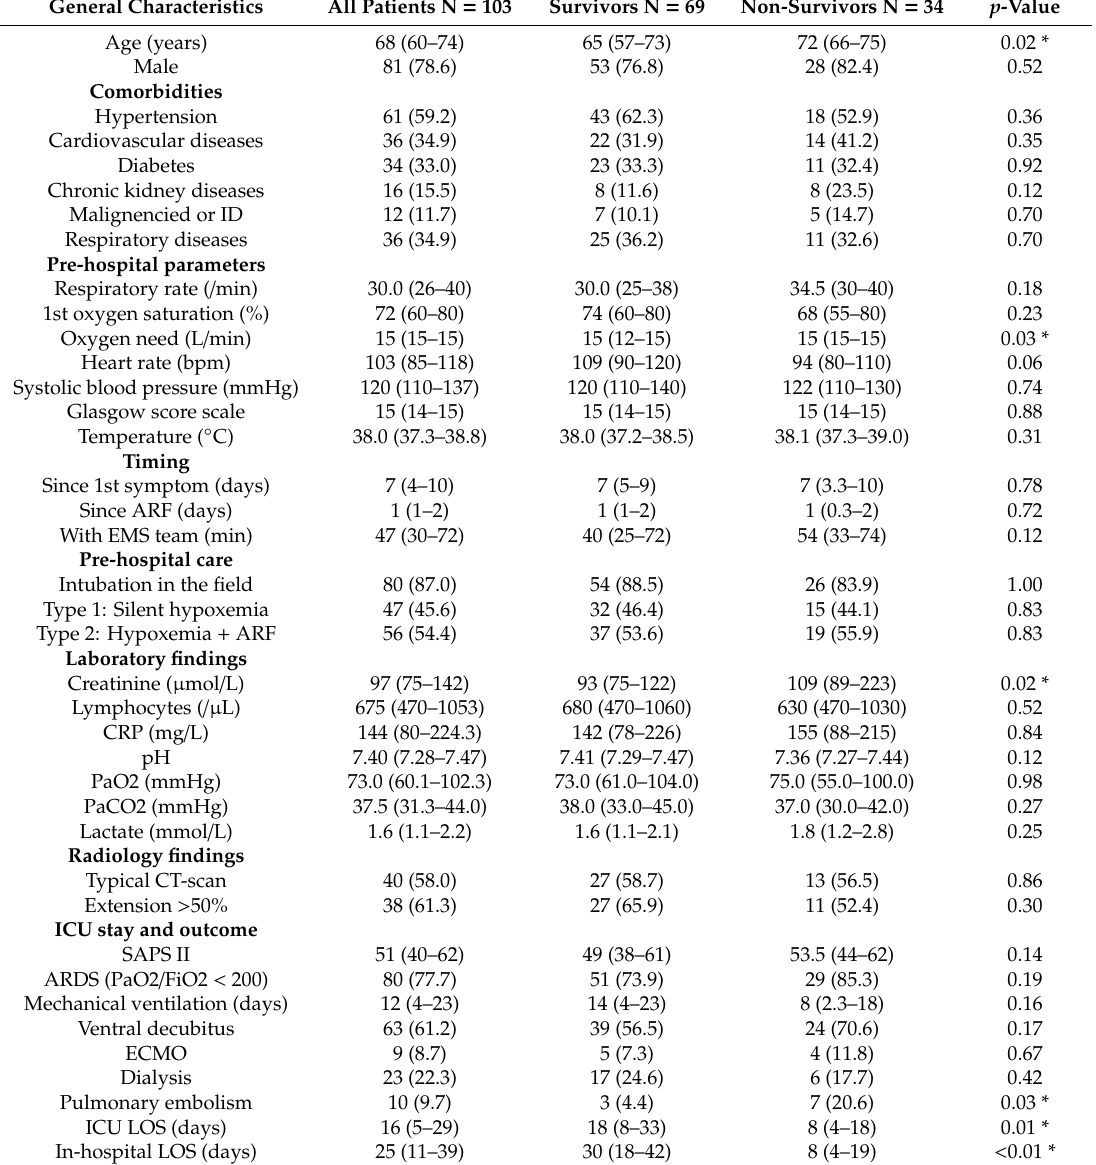
Table 1. Clinical characteristics at baseline and